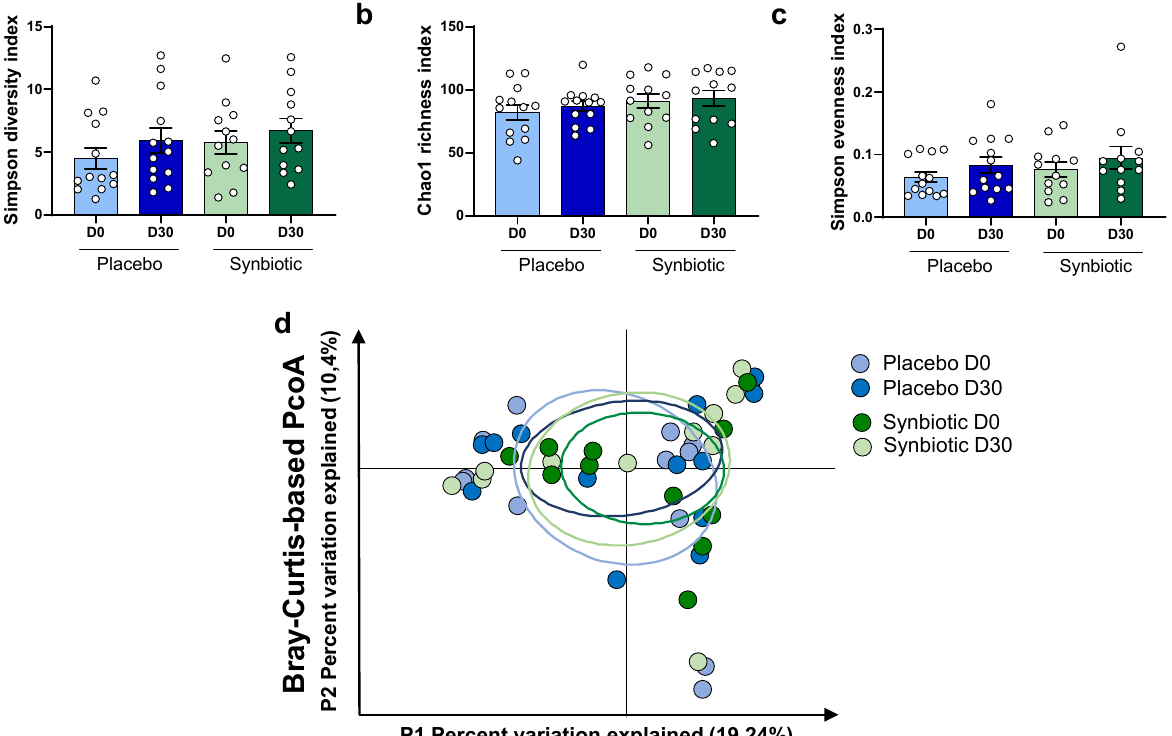
Figure 4. Alpha-diversity indexes ( a – c ) and principal coordinates analysis of the β-diversity index, Bray–Curtis ( d ) of the gut microbiota in middle-aged adults at baseline or after receiving placebo (n = 14) or synbiotic (n = 13) for 30 days. Data are mean ± SD. For α-diversity indexes, matched-pairs Wilcoxon signed-rank tests were performed to compare changes from baseline (within-group variations; p > 0.05). For β-diversity